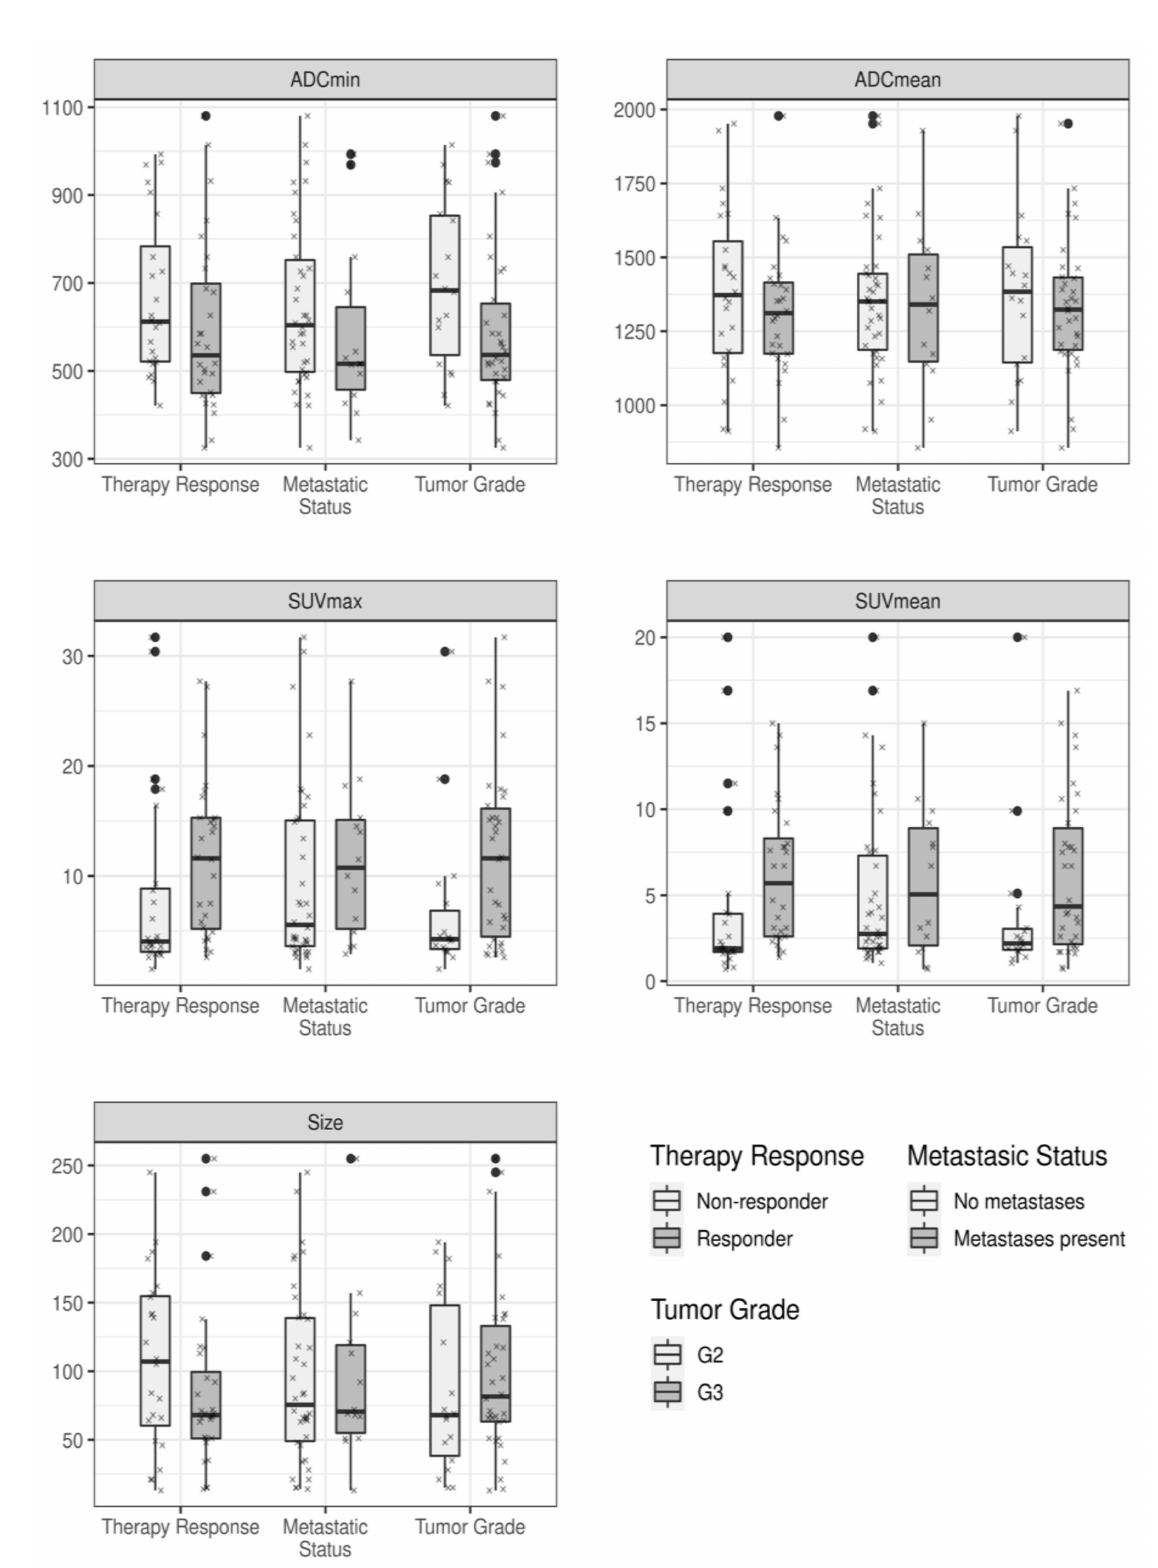
Figure 2. Measured quantitative imaging parameters in dependence of the different outcome variables, displayed as boxplots. Each box indicates the first and third quartile, while the whiskers indicate the 1.5 * inter-quartile range. Outliers, defined as values outside this range, are indicated by bold black dots. In addition, all measured values are indicated by small